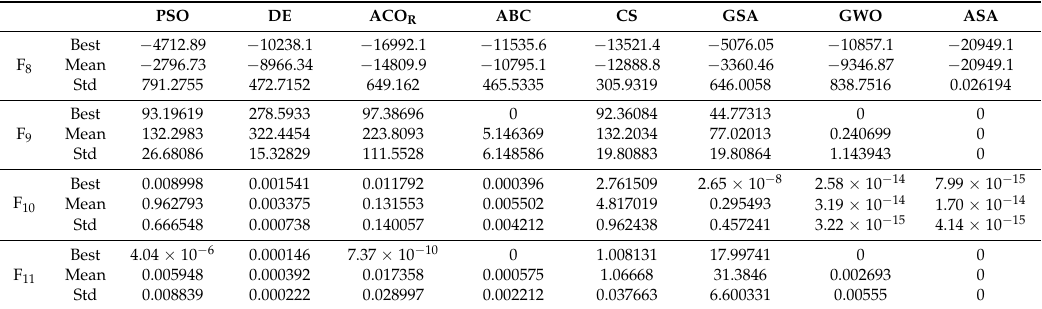
Table 4. Mean, best and standard deviation values of solutions achieved for multimodal test functions taken over 30